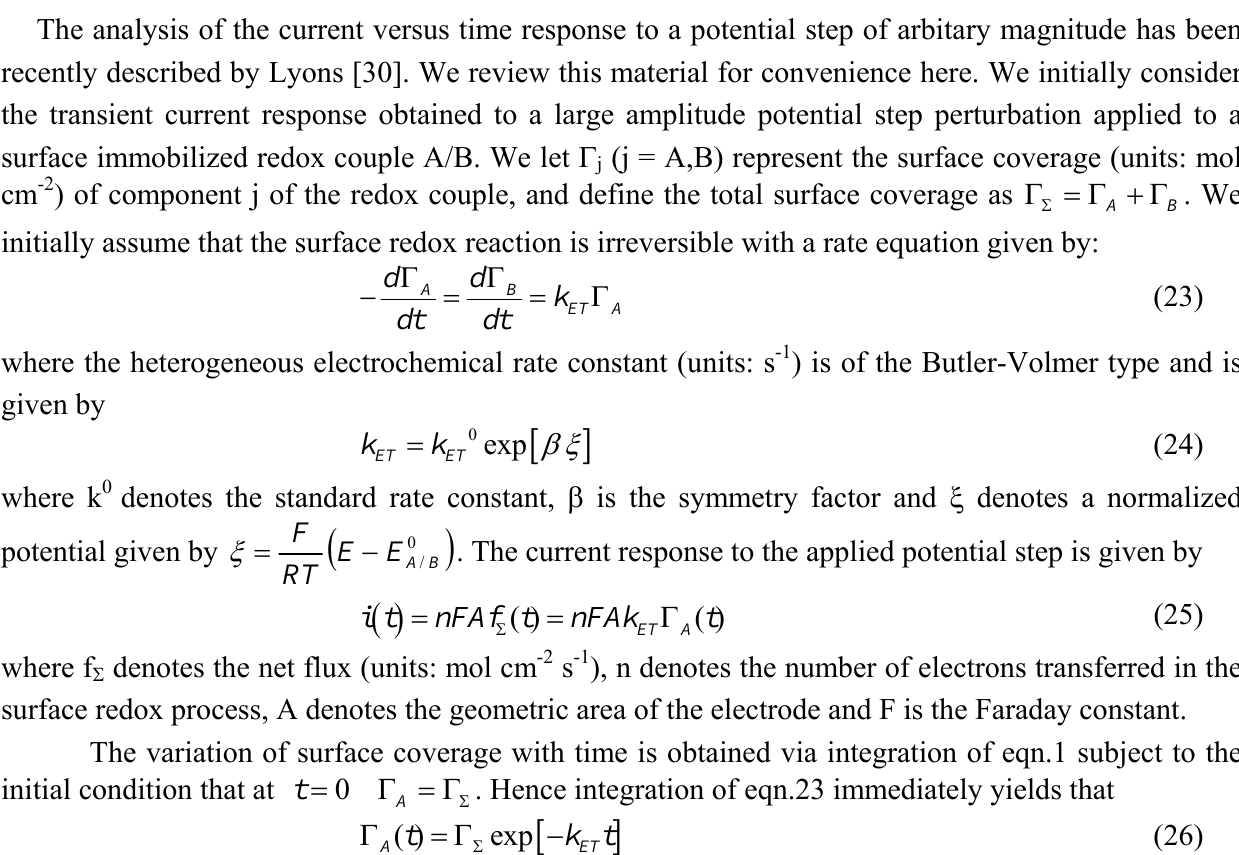
Figure 18. Typical outcome of a potential step experiment across the FAD oxidation and reduction potentials for a SWCNT/GOx/Nafion-modified gold electrode. The electrolyte used was a 50 mM phosphate buffer (pH